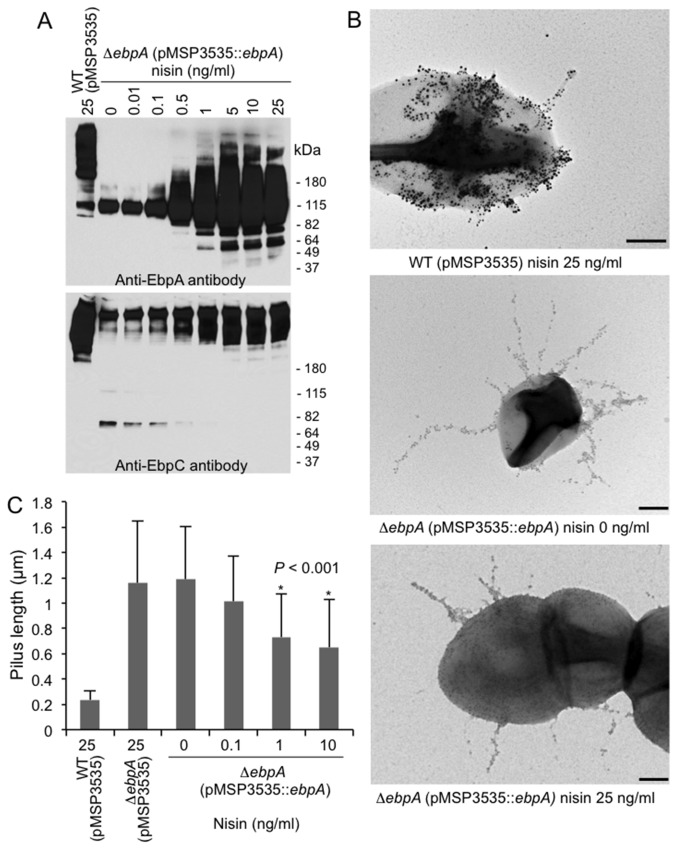
Effect of controlled overexpression of EbpA on pilus length.(A) Western blots ofmutanolysin cell wall extracts (CW) from complemented ebpA deletion mutant (OG1RFΔebpA (pMSP3535::ebpA)) grown in the presence of increasing concentrations of nisin. WT OG1RF with the empty vector (OG1RF (pMSP3535)), grown in the presence of 25 ng/ml nisin, is also shown. The membranes were probed with either anti-EbpA or anti-EbpC antibodies, as indicated. Positions of molecular weight markers are indicated. (B) IEM analysis of pilus production by cells harvested from similarly nisin-induced cultures as in panel A; stained with anti-EbpA (18 nm) and/or anti-EbpC antibodies (12 nm). Scale bars 200 nm. (C) Measurement of pilus lengths from the above IEM analysis. At least 22 pili were measured from each strain for each data point; means ± standard deviations are shown. The complemented ebpA deletion mutant (OG1RFΔebpA (pMSP3535::ebpA)) was found to produce significantly shorter pili (P < 0.01) after growth in the presence of 10 and 25 ng/ml nisin versus 0 ng/ml and theΔebpA empty vector control (ΔebpA (pMSP3535)).